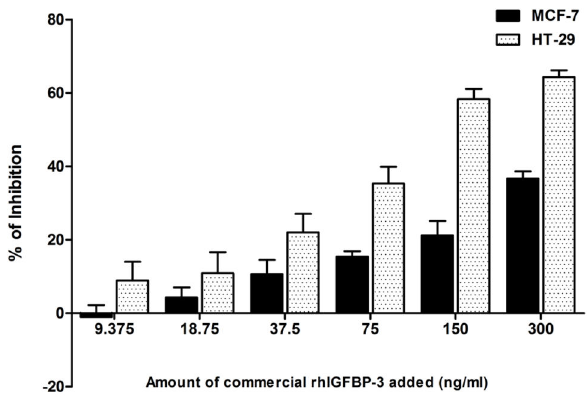
Figure 4. Inhibitory effect of commercial rhIGFBP-3 on human MCF-7 breast cancer cells and HT-29 colon cancer cells. Different concentrations of commercial rhIGFBP-3 ranged from 9.375 ng/ml to 300 ng/ml were used to treat MCF-7 and HT-29 cells. Data are shown as means ± SD.